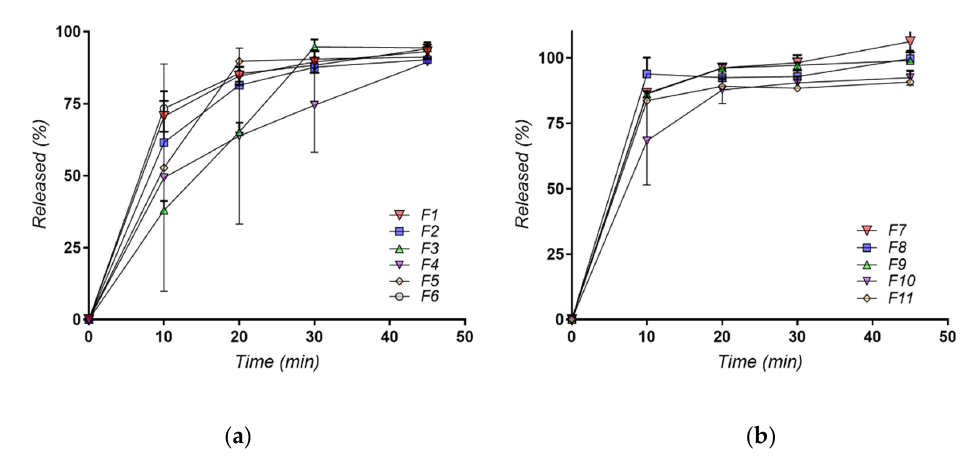
Figure 10. Dissolution profiles for formulations ( a ) F1–F6 and ( b ) F7–F11. Formulations with AMH mixtures with polymers showed that comparing the dissolu- tion rate between the solid dispersion of AMH in simple matrix of PEG4000 or